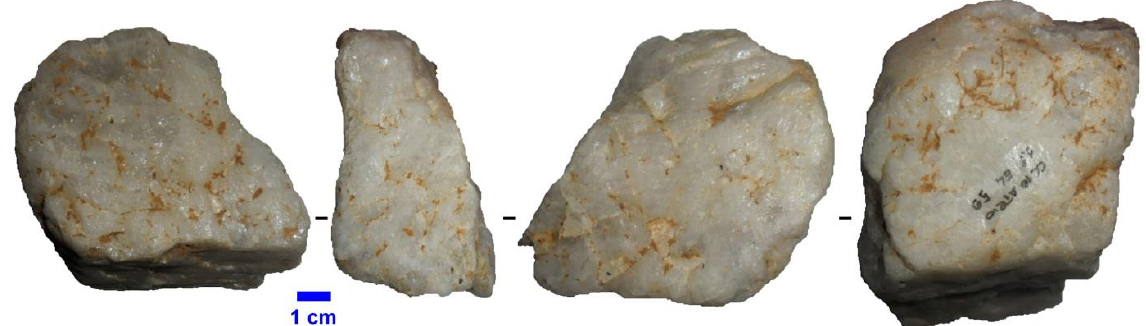
Figure 10. The Ciota Ciara cave. S.S.D.A. Core. The scale bar in the image is 1 cm